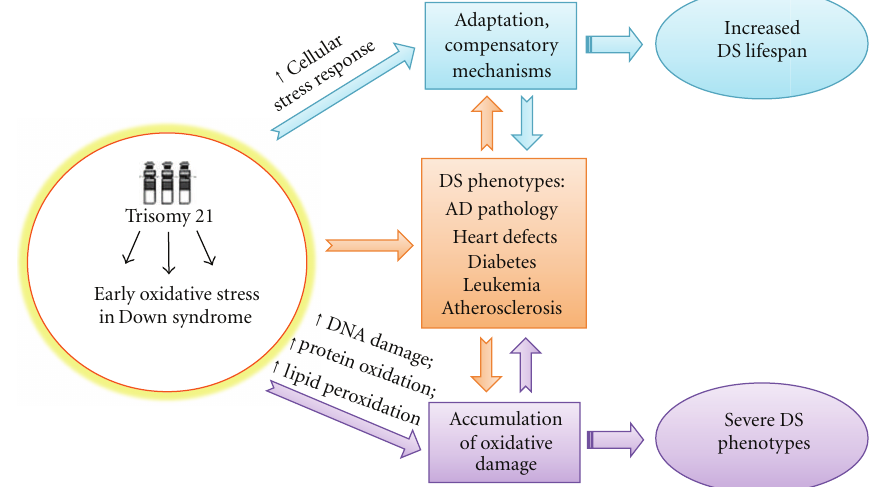
Figure 2: Putative adaptation to OS in down syndrome. OS occurs early in DS pathogenesis and progression. Accumulation of oxidative damage leads to severe phenotypes while the induction of compensatory mechanisms in response to chronic OS could result in “adaptation” and could contribute to improve the life span of DS